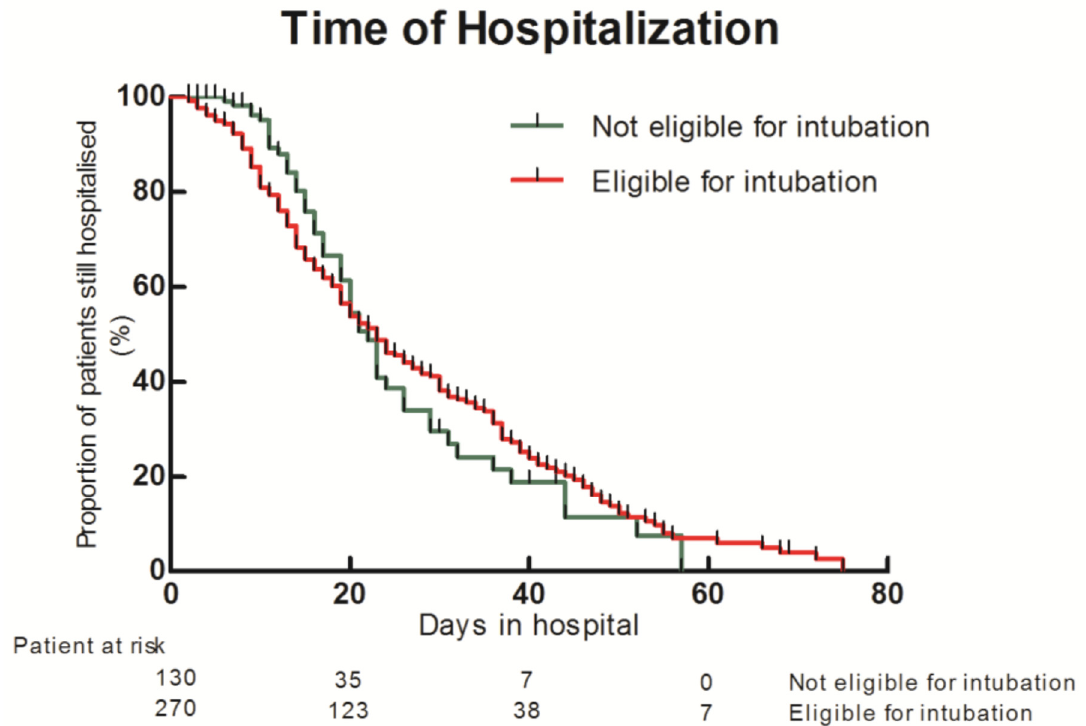
Figure 4. Kaplan–Meier of hospital length of stay between patient eligible to intubation and patients not eligible to intu- bation.